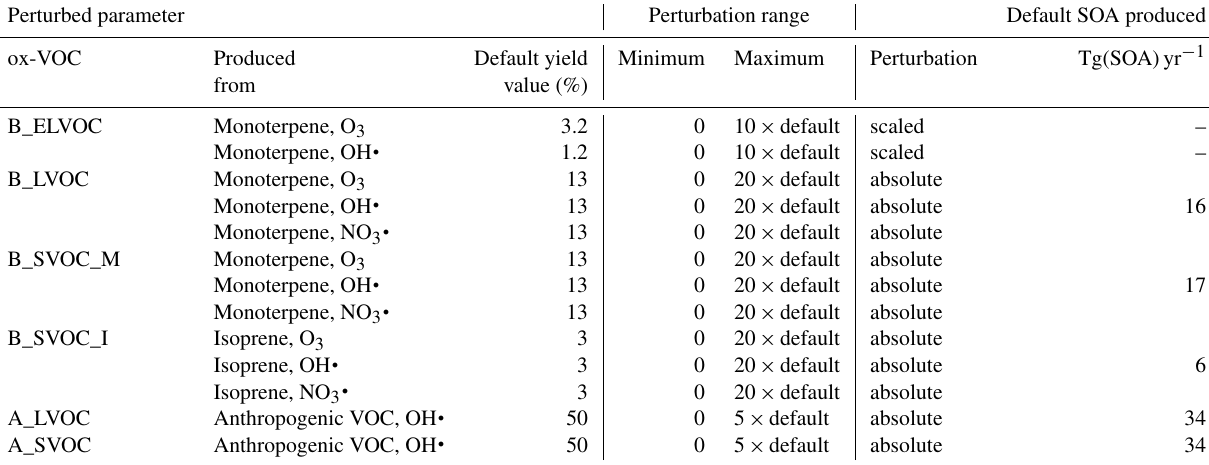
Table 2. Perturbed parameters and ranges. Also listed are the precursor VOC gases that produce the ox-VOCs, the value of ox-VOC yields in the default model version (unperturbed), how the perturbation for each parameter is implemented in the model (“absolute” for replacing the default yield value by the perturbation, “scaled” for scaling the default yield value by the perturbation), and the amount of SOA produced from each parameter in the default model